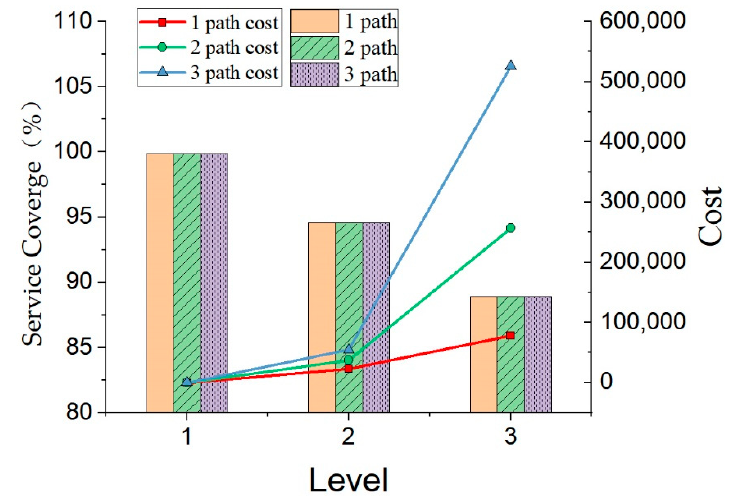
Figure 14. Impact of search path number on structure.